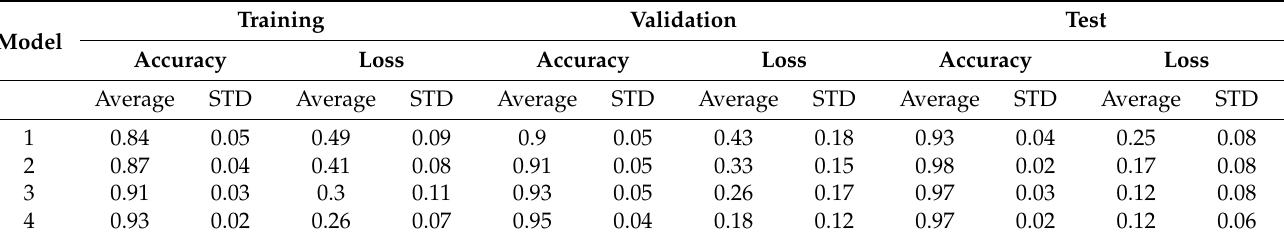
Table 2. Comparison of the proposed convolutional neural networks performance in various layer combinations provided from Table 1.